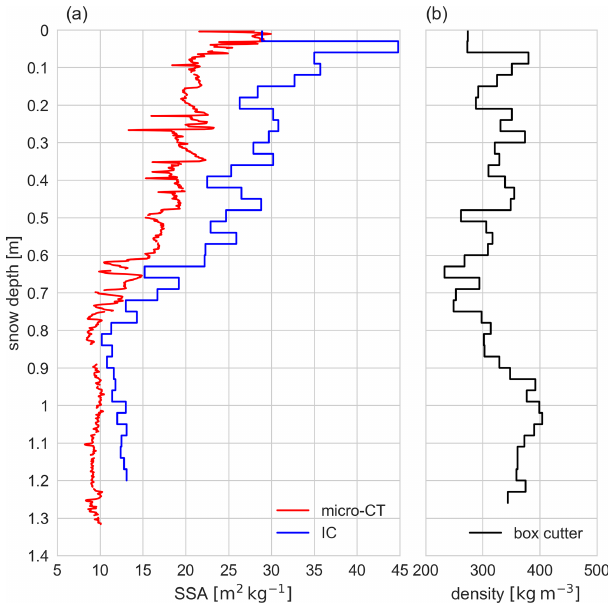
Figure 1. The data set with differing SSA measurement results for micro-CT and IC from the Greenland Summit (72 ◦ 34 (cid:48) 37.9 (cid:48)(cid:48) N, 38 ◦ 27 (cid:48) 03.6 (cid:48)(cid:48) W ) expedition in 2015 (Schneebeli et al., 2015). The snow surface is at 0m. Panel (a) presents the entire SSA profile (about 1.3m) measured with the micro-CT (red) and IC (blue). The IC has a 3cm measurement interval. Panel (b) shows the density profile (box cutter, volume 100cm 3